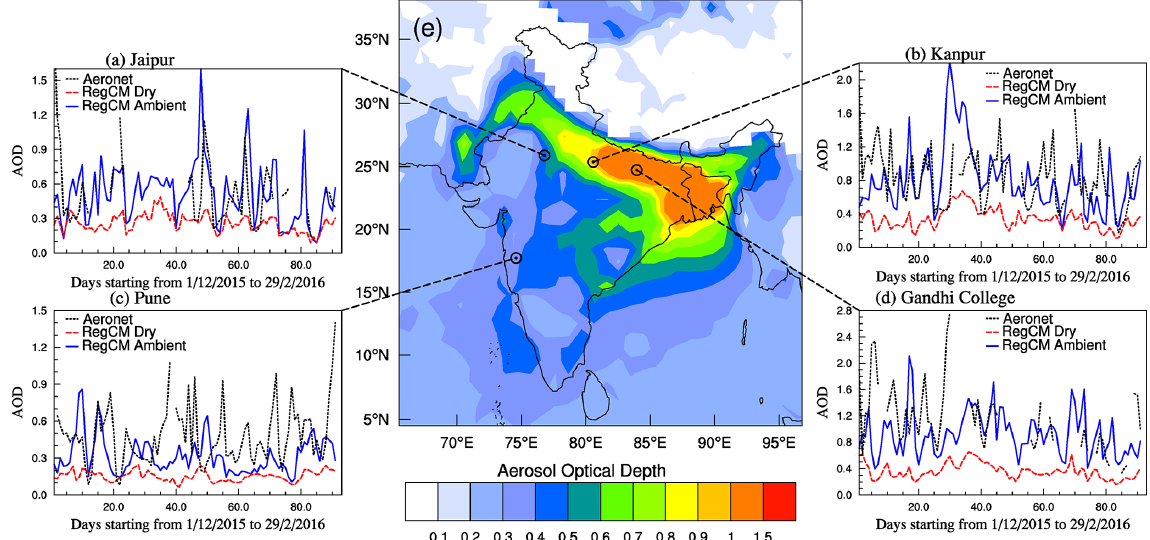
Figure 3. Wintertime AOD measured using AERONET radiometers and simulated with RegCM4 for ambient and dry humidity conditions with meteorological feedback at (a) Jaipur, (b) Kanpur, (c) Pune and (d) Gandhi College. Stations (b) and (d) are located in the IGP, while (a) and (c) are located outside the IGP. One season (December 2015–February 2016) of data is shown here for inter-comparison; the same is the case for the other years. (e) Spatial distribution of satellite-retrieved (MODIS) aerosol optical depth at